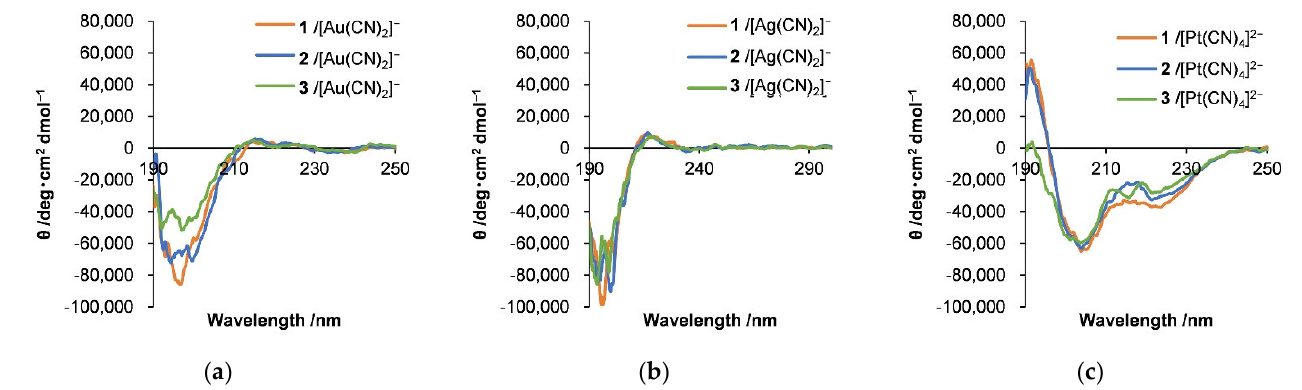
Figure 10. Circular dichroism spectra obtained from hybrids of ( a ) [Au(CN) 2 ] − , ( b ) [Ag(CN) 2 ] − , and ( c ) [Pt(CN) 4 ] 2 − with diblock copolypeptide amphiphiles 1–3, where [Au(CN) 2 ] − = 3.5 mM, [Ag(CN) 2 ] − = 5.0 mM, and [Pt(CN) 4 ] 2− = 2.7 mM.